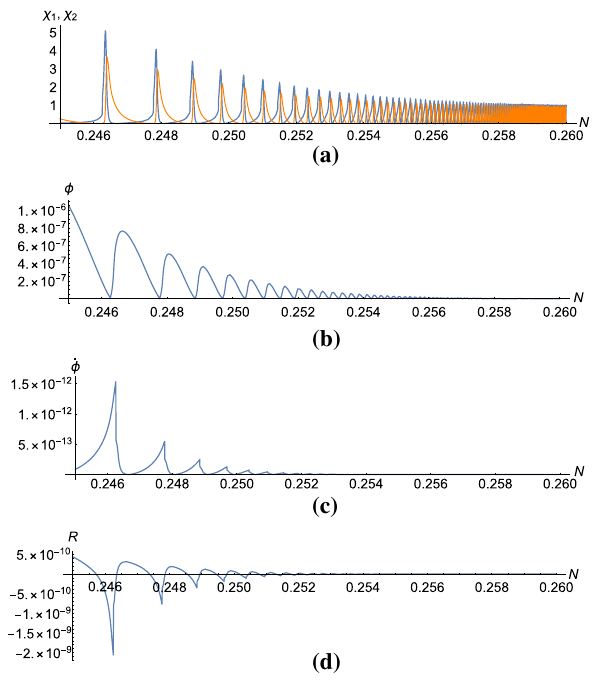
Fig. 11 From top to down: χ 1 , 2 , φ 2 , ˙ φ 2 and Ricci scalar. The initial conditions are χ 1 ( N = 0 ) = 100, χ 2 ( N = 0 ) = 100 with ξ = 1000, M p = 1 and λ = 1. This set of initial conditions has been chosen such that the de Sitter expansion has ignorable e-fold duration. By this, the numerical simulation leads to more resolution on the oscillations. To have more clear perspective, the range of the e-folds N has been chosen in an interval where the amplitudes of oscillations are